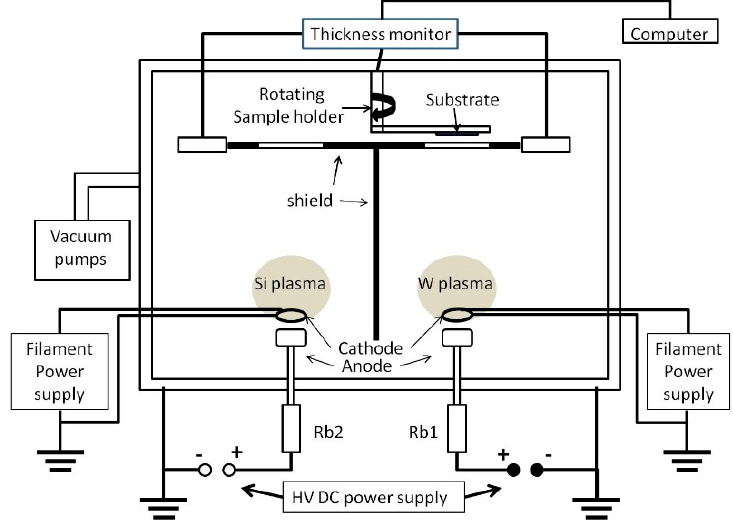
Figure 1. Experiment setup with two high-voltage anodic-plasma sources used for nano- and multilayer deposition.